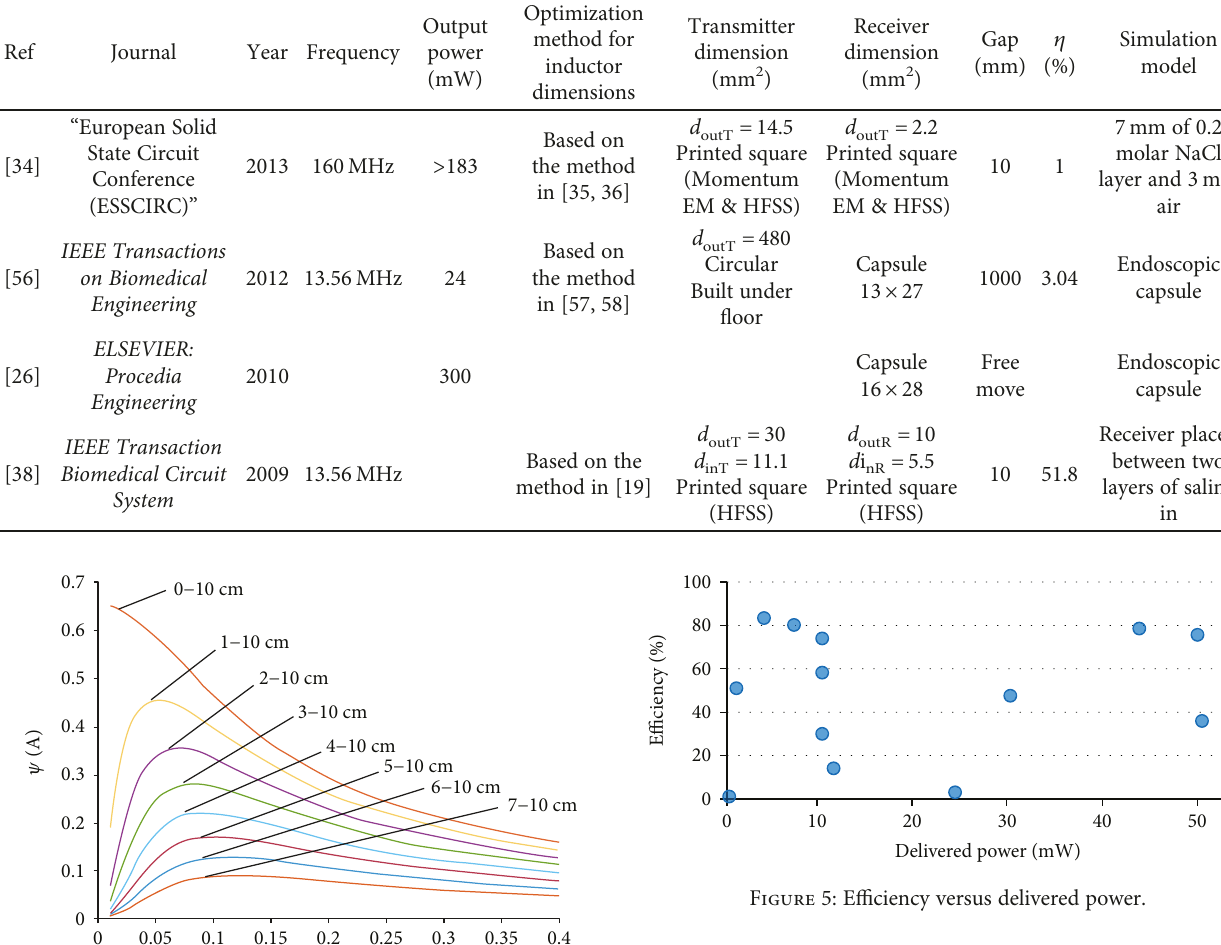
Table 4: Other model of implantable power device.